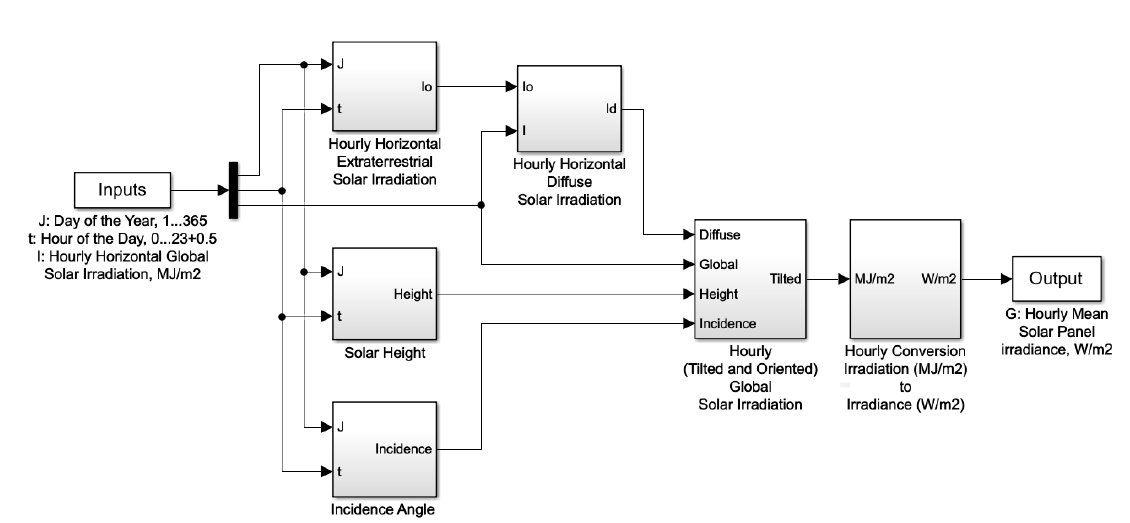
Figure 1. Methodology for estimating the measured values of global irradiance on a horizontal surface with the estimates received by the inclined plane of the solar panel.